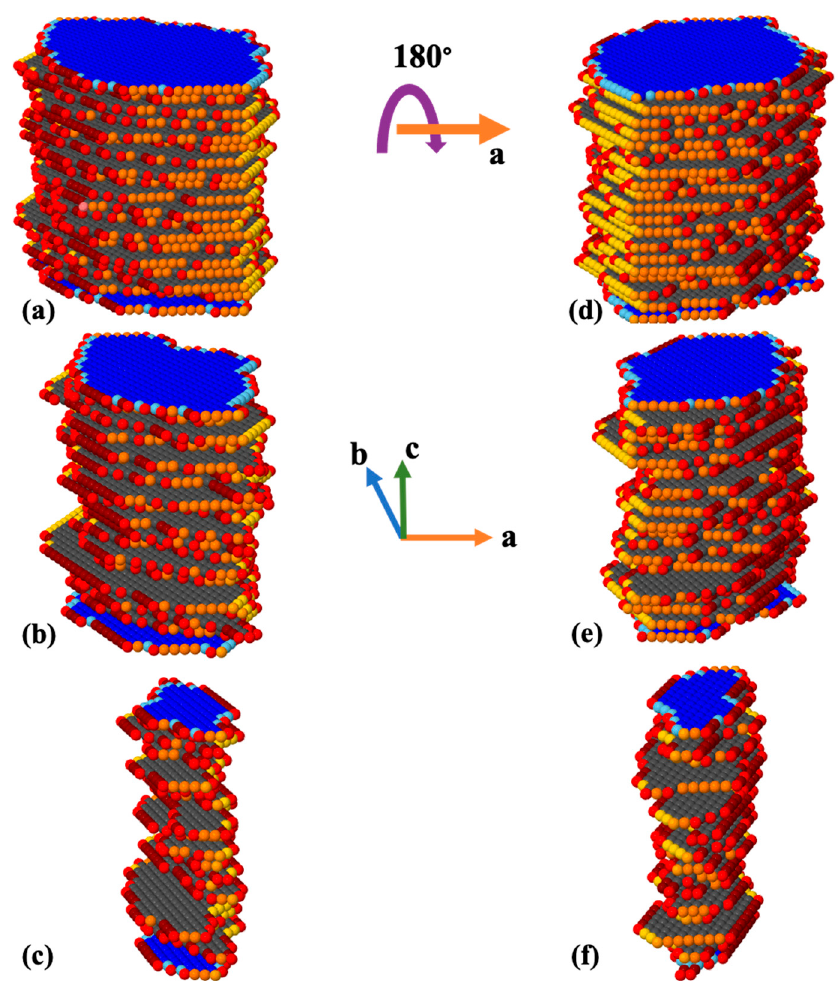
Figure 5. Evolution of calcium hydroxide crystal morphology during an atom-by-atom site dissolution KMC simulation. Initial crystal (Figure 4) consists of 17,461 sites, and after 5250 ( a , d ), 10,500 ( b , e ), and 15,750 ( c , f ) dissolution steps. Each step is representative of one site dissolution. Figures on the right side ( d – f ) represent a 180-degree rotation about ( a ) axis of the crystals on the left side ( a – c ).